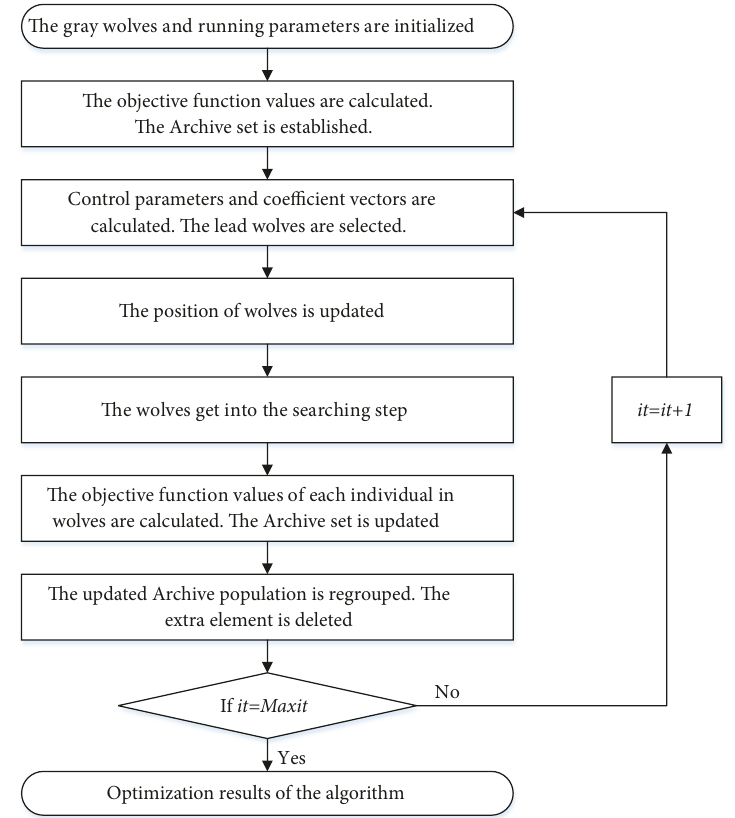
Figure 4: The flow chart of the sMOGWO